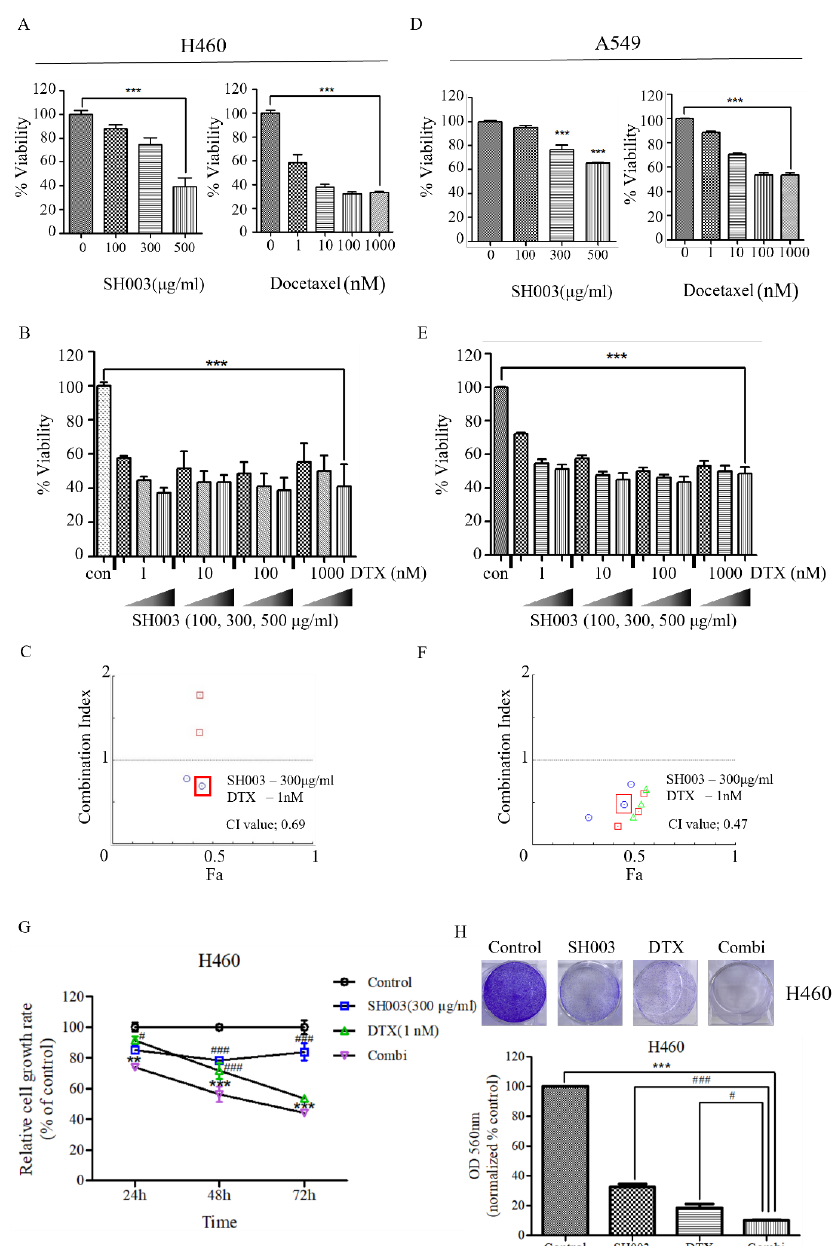
Figure 1. Effect of SH003 and docetaxel on the growth of H460 and A549 non-small-cell lung cancer cell lines. ( A , D ) Effect of single-drug treatment with SH003 or docetaxel on H460 and A549 cells. ( B , E ) Effect of combination treatment with SH003 and docetaxel on H460 and A549 cells. A cell viability assay kit was used to detect the proliferation of H460 and A549 cells treated with SH003 and docetaxel at various concentrations for 48 h. ( C , F ) Synergistic effect of SH003 and docetaxel was determined by combination index (CI) using CompuSyn software. CI < 1, CI = 1, and CI > 1 correspond to synergistic, additive, and antagonistic effects, respectively. ( G ) Proliferation of H460 cells treated with the SH003, docetaxel, or their combination, expressed as relative cell growth rate (% of control). Statistical significance was determined using the two-way ANOVA with Bonferroni post-tests. ( H ) H460 cells stained with crystal violet 5 days after treatment of SH003, docetaxel, or a combination of each drug. ( A – F , H ) Error bars are SEM of cells treated, n ≥ 3. Statistical significance was determined using the one-way ANOVA with Tukey’s test comparing control cells with SH003- or docetaxel-treated cells. ** p < 0.01, *** p < 0.001 versus control, and # p < 0.05, ### p < 0.001 versus